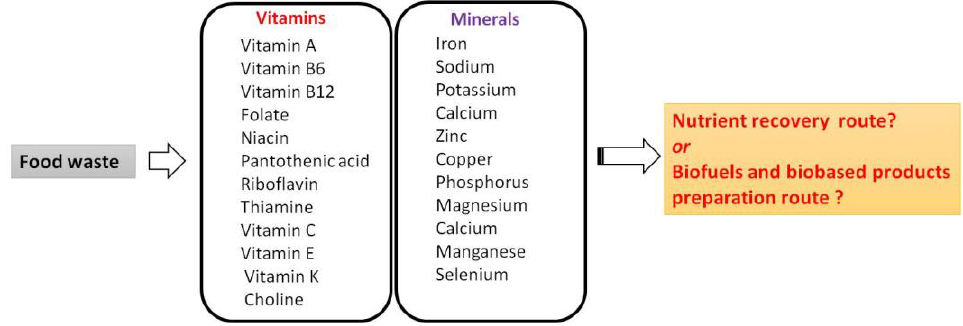
Figure 22. Nutrient recovery from food